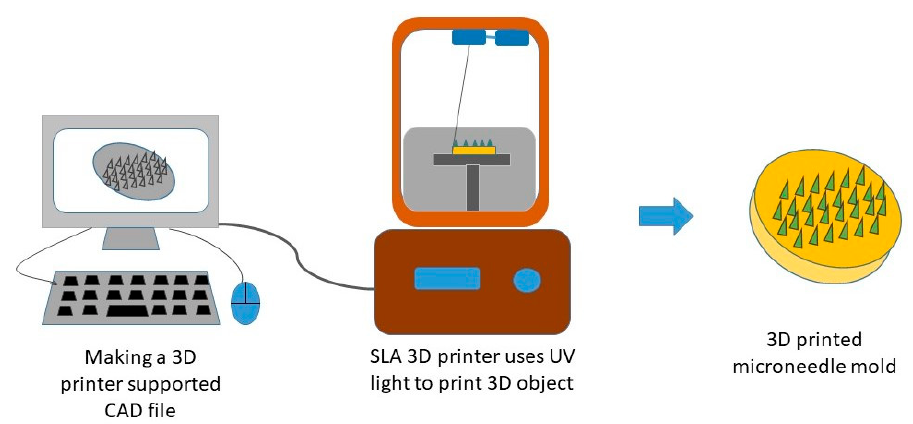
Figure 9. Illustration of the process involved in 3D printing of polymeric MNs. Adapted from [162], Springer Nature, 2019.